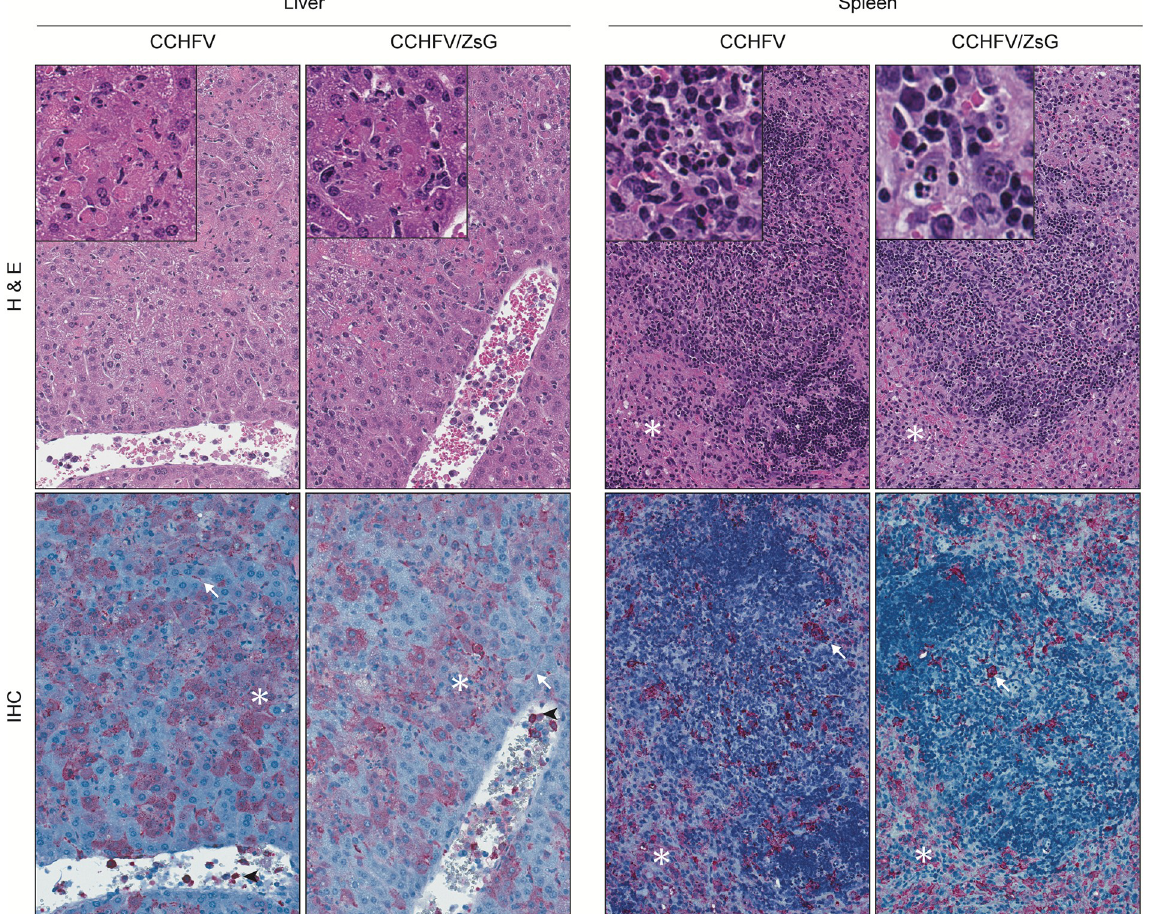
Fig 2. Liver and spleen pathology and CCHFV distribution visualized by immunohistochemistry in mice euthanized at 5 dpi. Mice displayed similarly severe pathology with abundant CCHFV immunostaining. Livers had widespread, random, and confluent hepatocellular necrosis (see insets) with minimal inflammation. Central veins of these mice contained increased numbers of leukocytes. CCHFV was detectable by immunostaining within necrotic and viable hepatocytes ( ✱ ), sinusoidal lining cells (arrows) including Kupffer cells and endothelium, and intravascular leukocytes (arrowheads). In spleens, lymphocytolysis (see insets) and red pulp expansion by histiocytes ( ✱ ) were observed, and immunostaining showed scattered CCHFV within lymphoid follicles (arrows) and extensive within red pulp histiocytes ( ✱ ). H&E, hematoxylin-eosin staining; IHC, CCHFV immunoalkaline phosphatase staining with naphthol fast red substrate, hematoxylin counterstain. Original magnification: liver, 200 × ; spleen, 200 ×